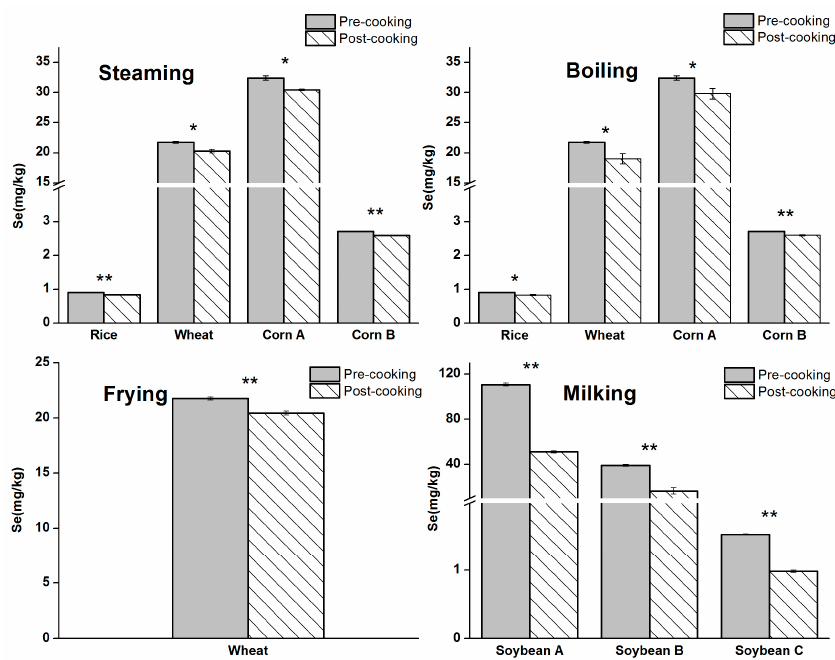
Figure 3. Selenium loss from the cereals and soybeans in the processes of the four cooking methods ( n = 3). * means p < 0.01, ** means p < 0.001 (two sample t test on normally distributed data, Origin Pro 8, (Origin Lab, Northampton, MA, USA.)).